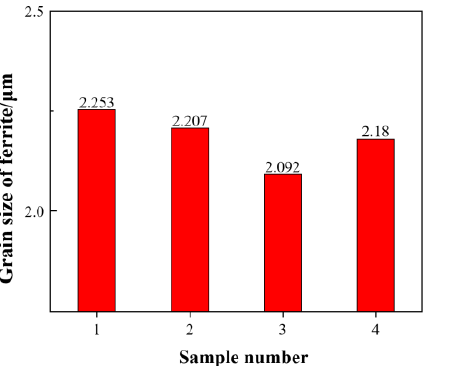
5 of 10 Figure 2. Grain size distribution of FeCrAl ODS steels with different Zr contents: ( a ) 0 wt.%, ( b ) 0.3 wt.%, ( c ) 0.6 wt.%, ( d ) 1.2 wt.%. Figure 3 shows the calculated average grain sizes in the as-prepared samples based on Figure 1. As observed, the grain sizes of FeCrAl ODS steel samples with Zr addition are all smaller than that of the sample without Zr addition, suggesting that the addition of the Zr element can refine the grains. With the increase of Zr content, the grain size decreases first and then increases. When the